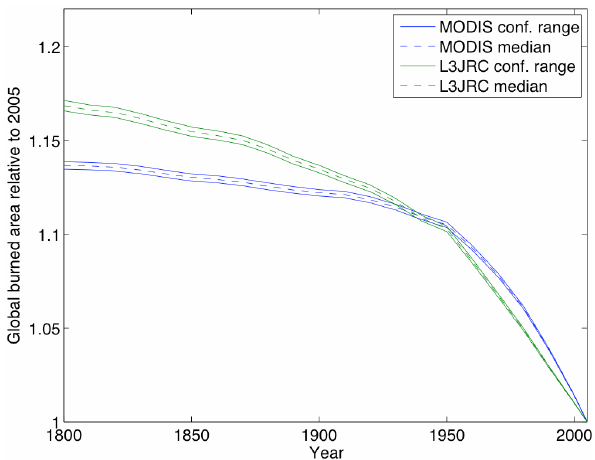
Fig. 7. Inferred historical change in global burned area normalized to the 2005 value using observed burned area and historical human population density. Ranges refer to 95% confidence interval.